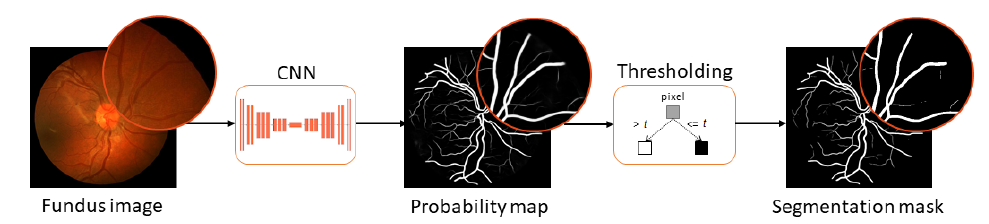
Figure 1. A typical retinal vessel segmentation workflow consists of probability map inference from an input fundus image followed by thresholding t to create a binary segmentation mask from the probability